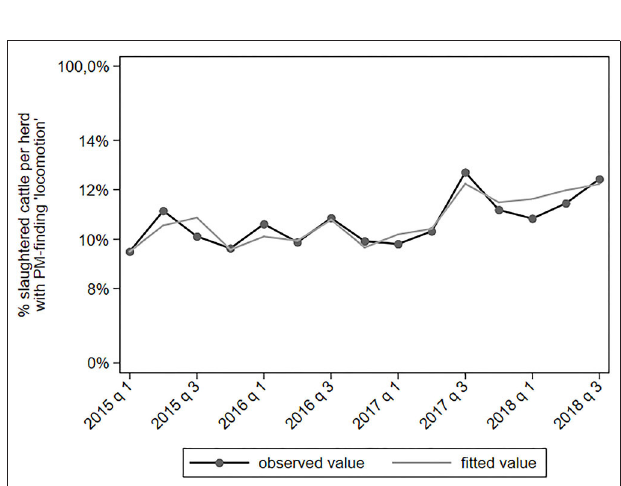
FIGURE 7 | Observed and predicted percentage of slaughtered cattle per dairy herd with a PM-finding categorized under “integumentary,” per quarter between January 2015 to September 2018 ( N = 78,366).